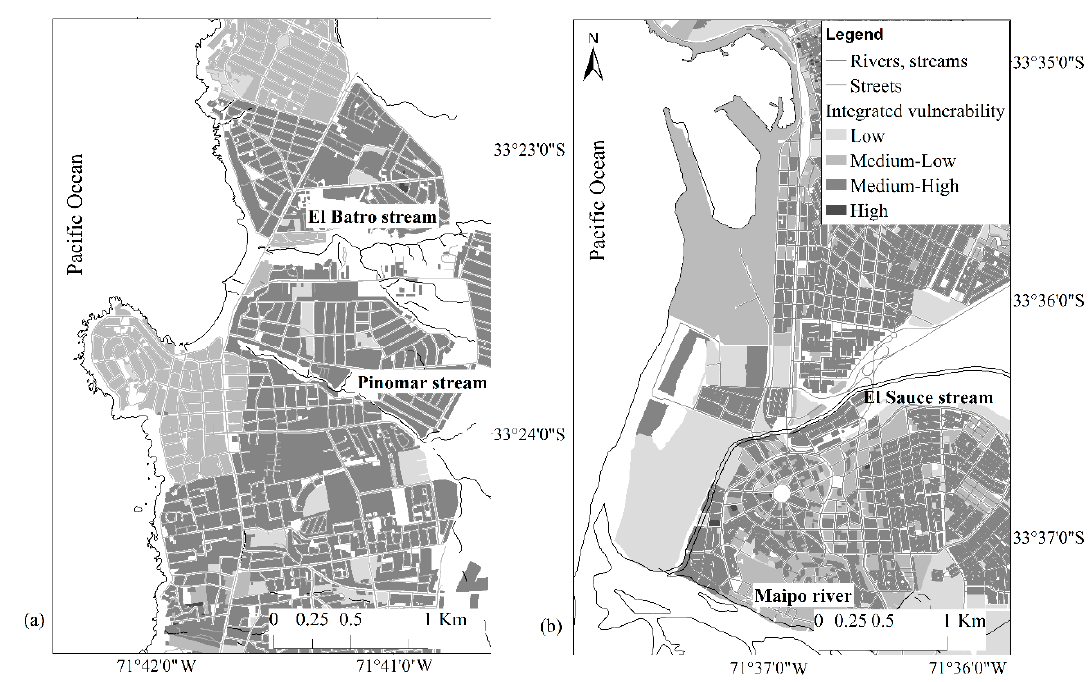
Figure 7. Integrated vulnerability of housing in ( a ) El Quisco and ( b ) San Antonio.